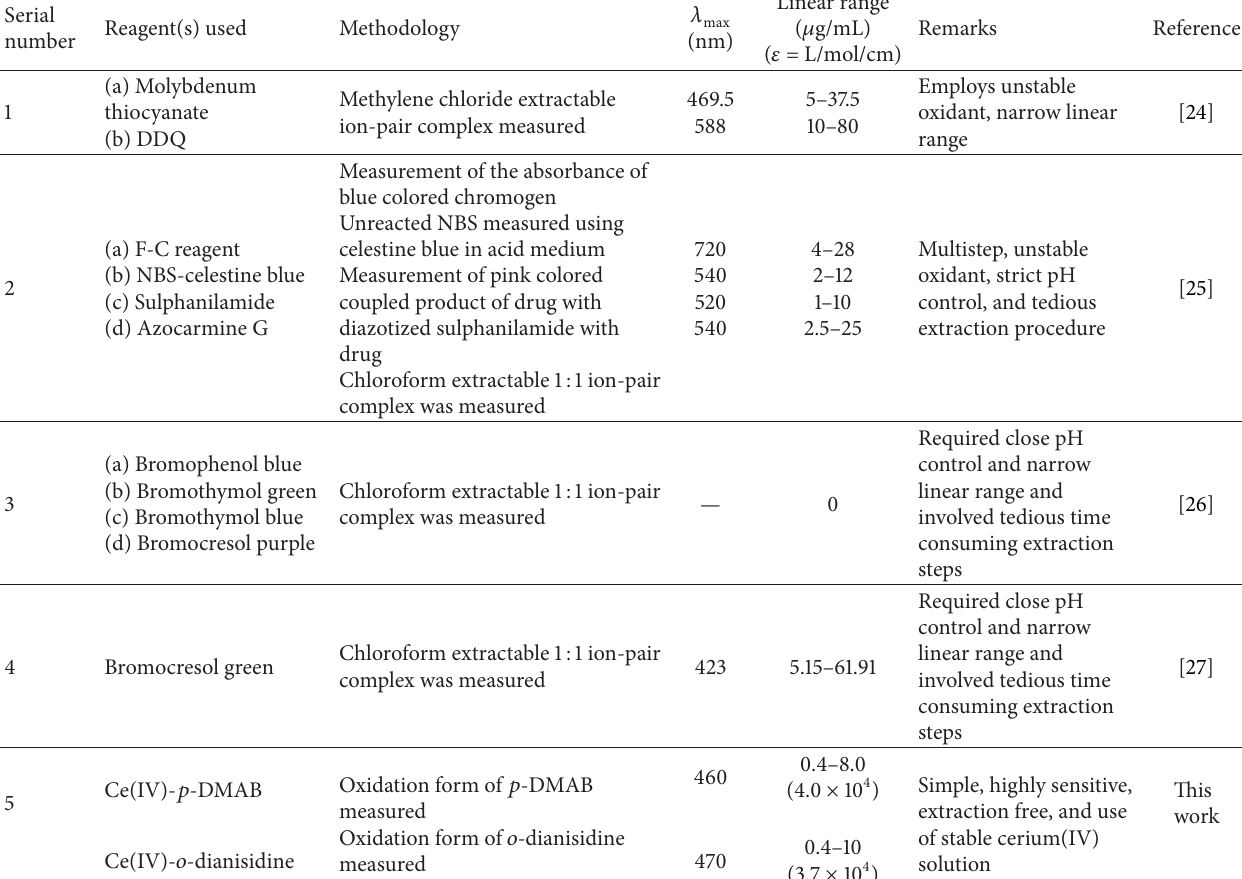
Table 1: Comparison of the performance characteristics of the proposed methods with the existing visible spectrophotometric